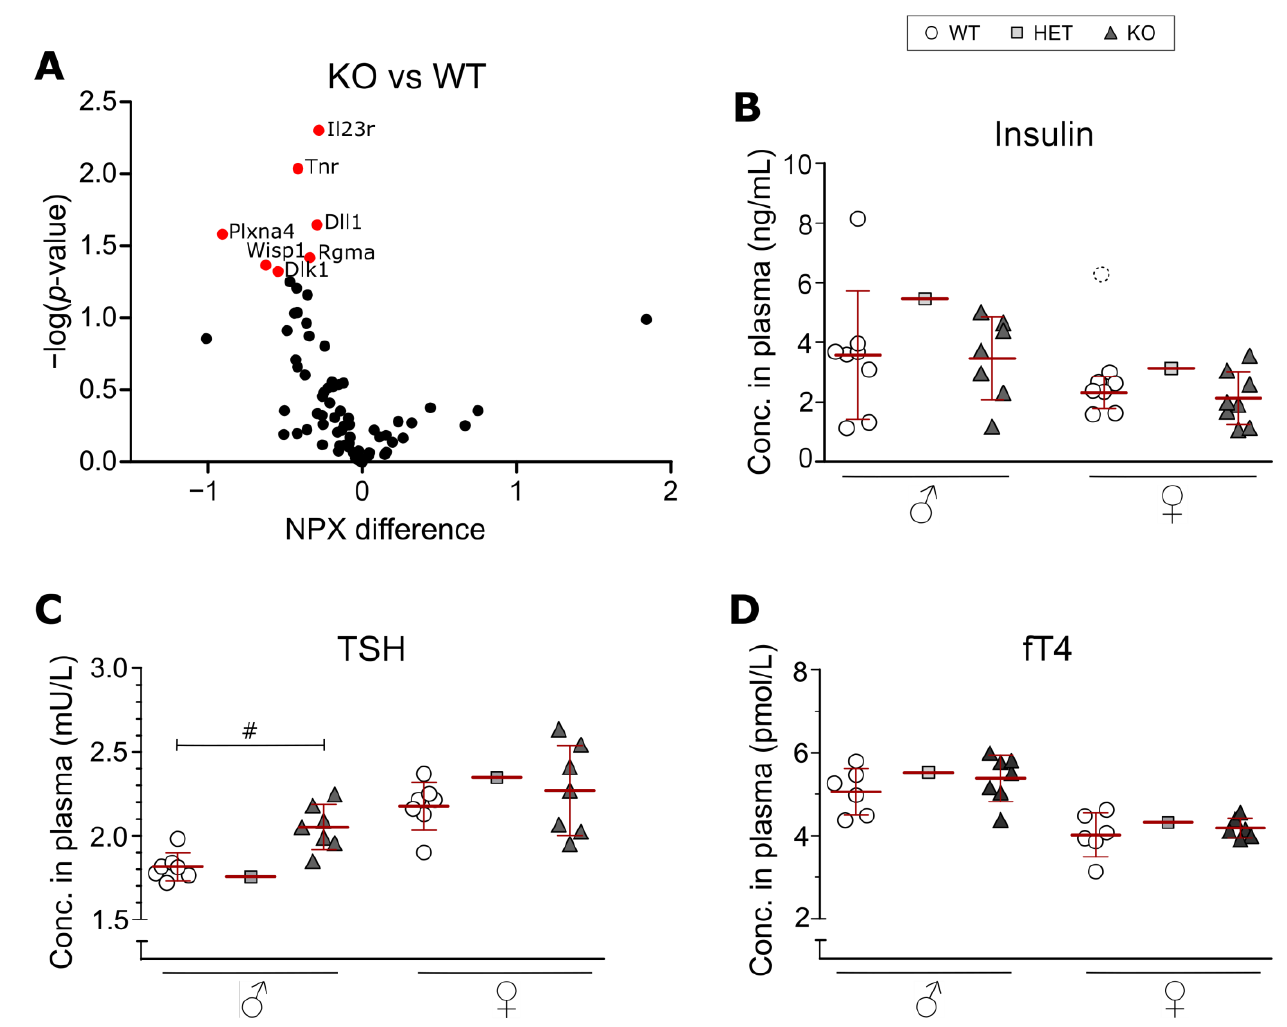
Figure 4. Protein expression levels in plasma of SLC38A10 KO mice. Blood was collected from adult mice, and the plasma was used for an Olink mouse exploratory panel and ELISA measurements of TSH, fT4 and insulin. ( A ) The mouse exploratory panel (Olink Proteomics AB, Uppsala, Sweden) was used to analyze 92 proteins related to a wide range of functions. In total, 78 proteins were detected, and each plotted with its NPX difference (KO relative to WT) against p -value. Data were analyzed with unpaired t-tests and with FDR correction (FDR set to 0.05). Proteins in red were statistically different between the genotypes after t-tests, but not after FDR correction. ( B ) Insulin (n = 8 WT, 7 KO males; 7 WT, 8 KO females), ( C ) TSH (n = 7 WT and 7 KO per sex) and ( D ) fT4 (n = 6 WT, 7 KO males; 6 WT, 6 KO females) levels in plasma were measured with sandwich ELISA. One pooled HET sample (from 7 animals) per sex was included in the experiment, but not statistically analyzed. Outliers (significantly different from the other data points according to Grubbs’ outlier test) were excluded from the analysis but plotted in the figure with dashed lines. KO and WT data were analyzed with an unpaired t-test with Bonferroni correction (adjusted p -value, # p < 0.01667). ( B – D ) Data are illustrated as individual data points and with mean ± standard deviation. NPX: Normalized Protein